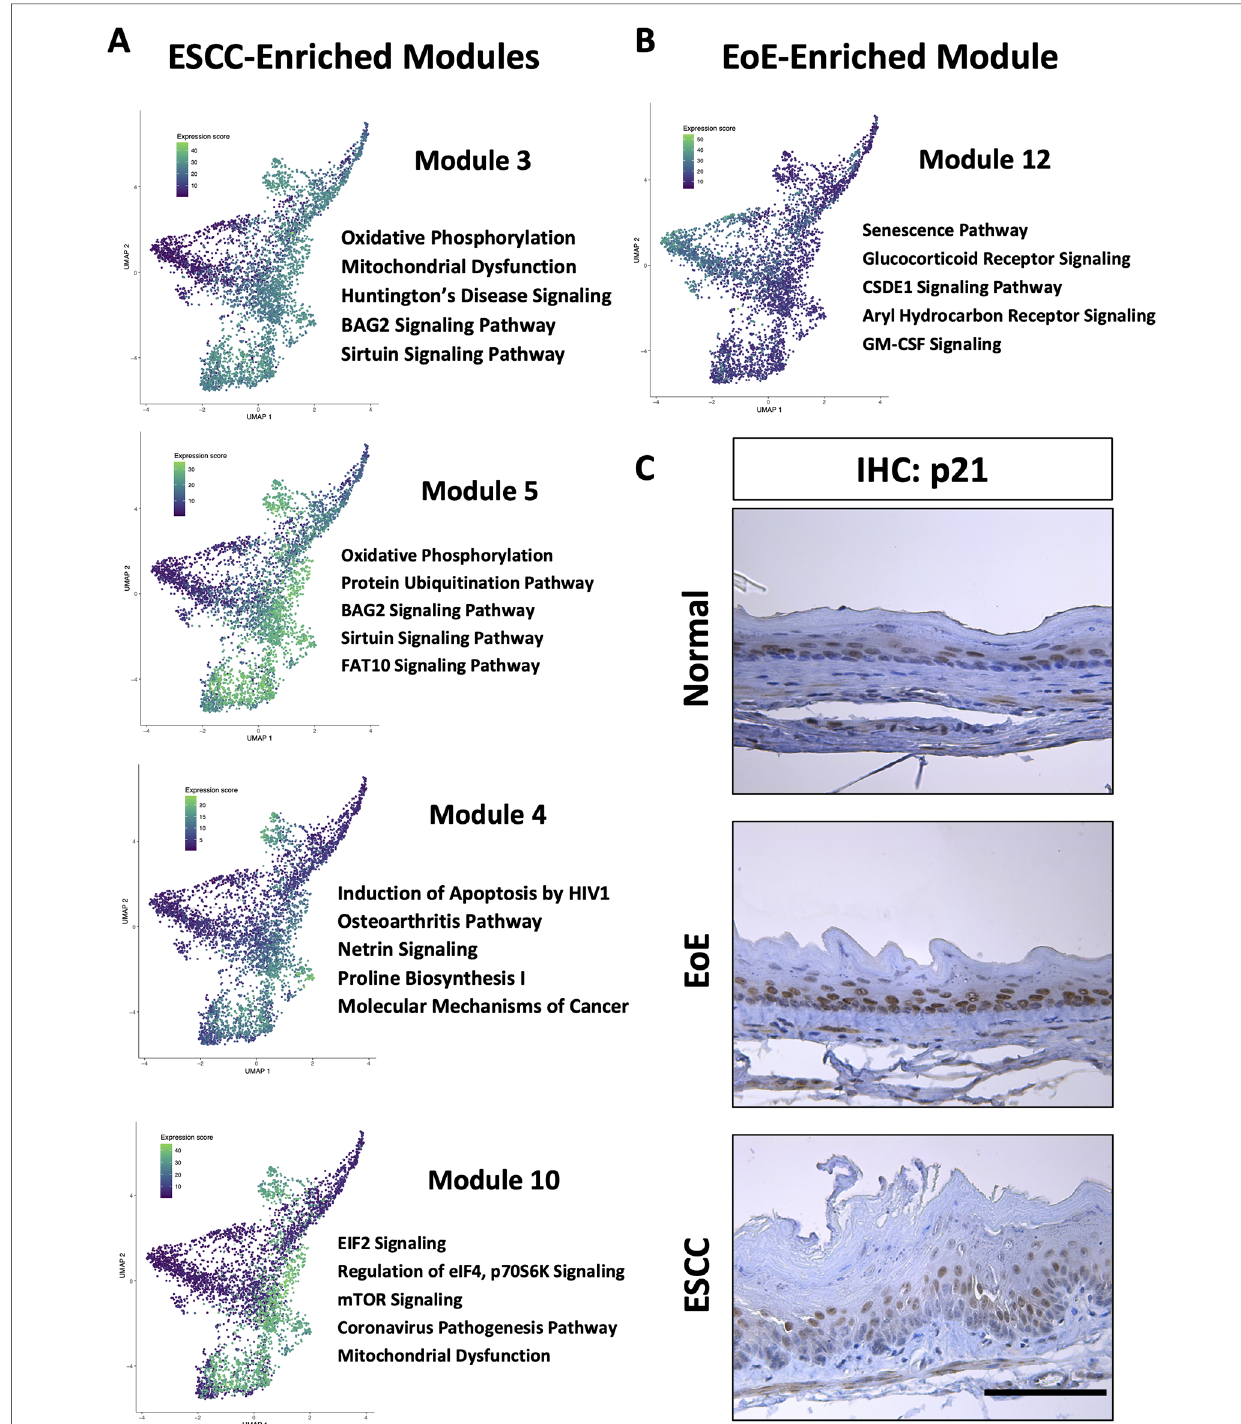
FIGURE 6 Pathways associated with cell populations that are enriched in mice with esophageal squamous cell carcinoma (ESCC) or eosinophilic esophagitis (EoE). ( A,B ) Ingenuity Pathway Analysis (IPA) identi fi ed cellular processes predicted to be signi fi cantly altered in co-expressed genes in modules that are associated with populations enriched in mice with ESCC in A or EoE in B. Associated Uniform Manifold Approximation and Projection plots (UMAPs) show normalized expression levels of each module across the entire single cell RNA-Sequencing dataset with green indicating high expression and purple indicating low expression. Top 5 pathways predicted to be most signi fi cantly associated with each gene module are listed. ( C ) Immunohistochemistry for p21 in mice with MC903/Ovalbumin-induced EoE, 4-nitroquinoline 1-oxide-induced ESCC or untreated controls (designated normal). Scale bar, 100 μ